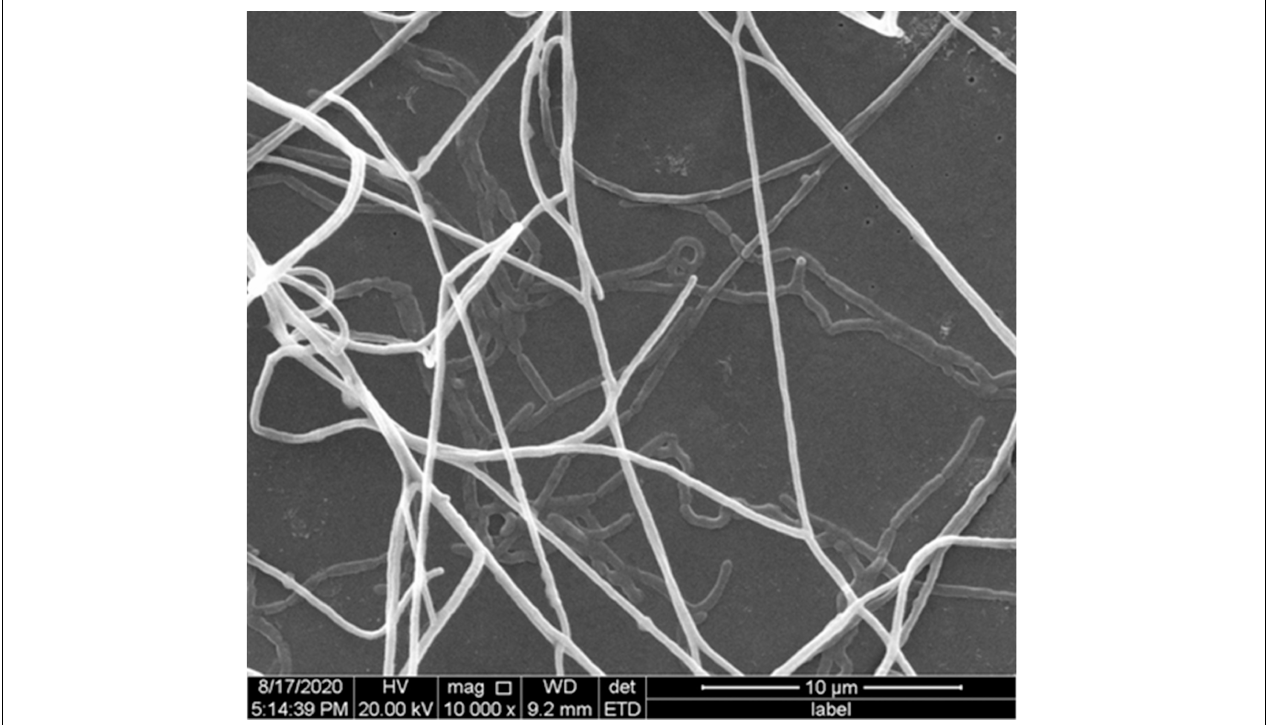
FIGURE 2 | Scanning electron micrograph of the aerial mycelium and substrate mycelium of strain YIM 96748 T on ISP 2 with 5% ( w / v ) NaCl concentration after incubation for14 days. Bar , 10 µ m.